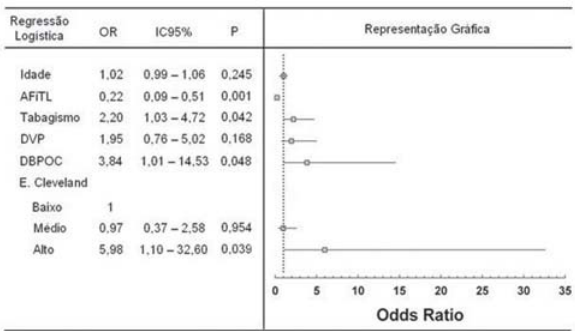
Tabela 5. Fatores avaliados quanto à influência no tempo de hospitalização.